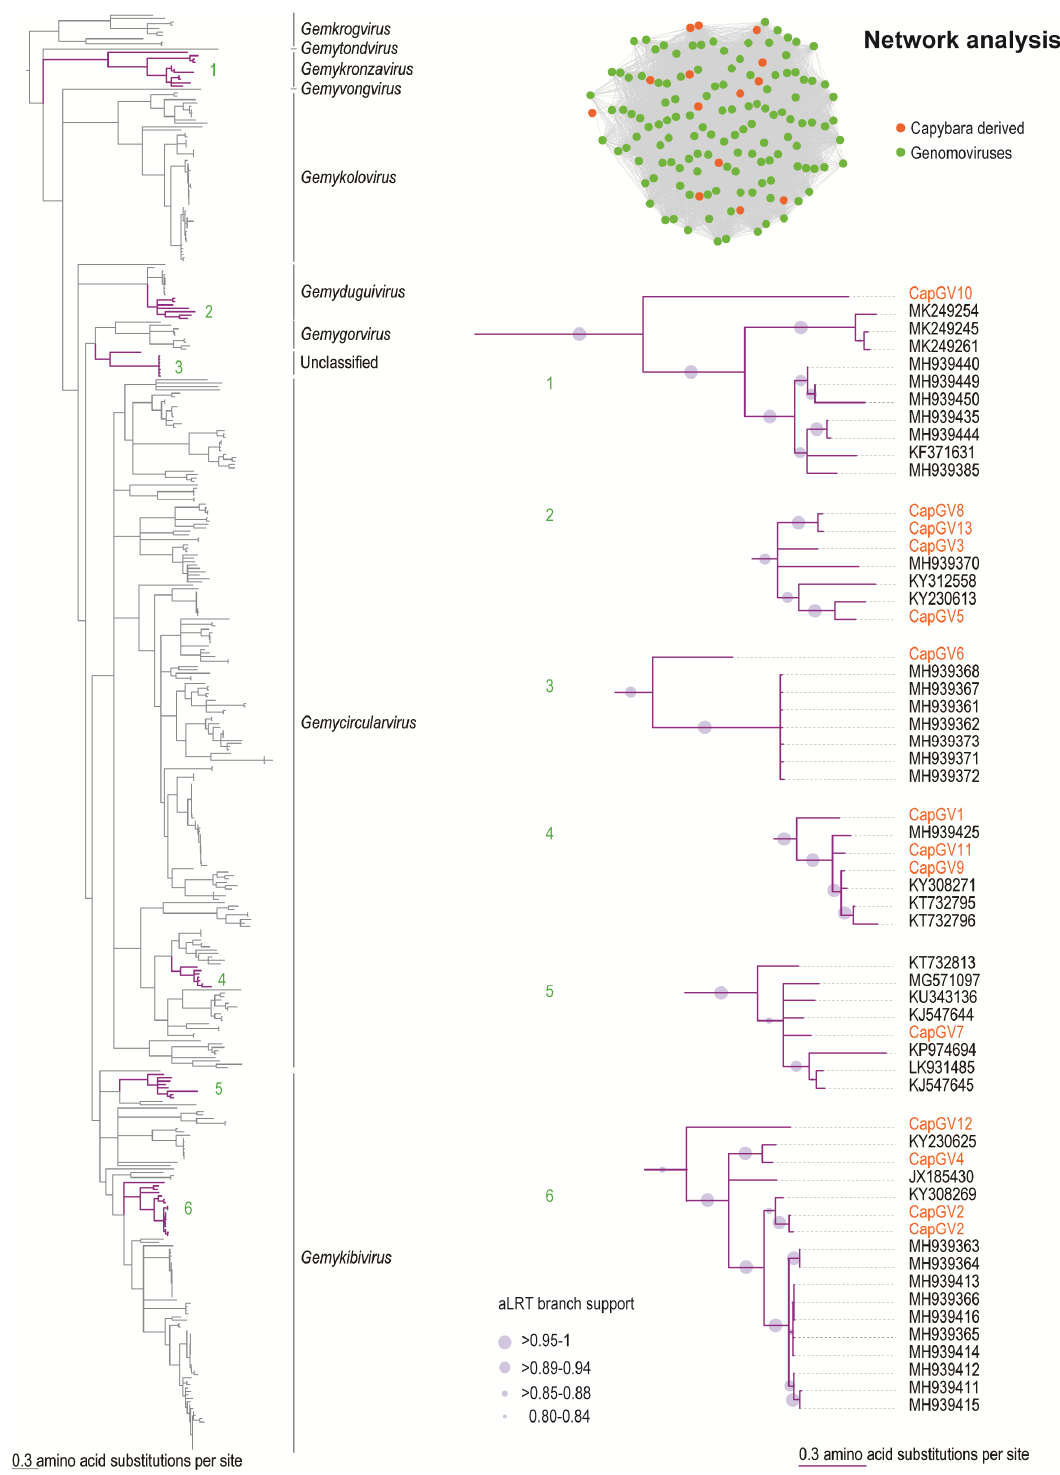
Figure 2. Sequence similarity network analysis and Maximum Likelihood phylogenetic tree of the Rep amino acid sequences of the viruses belonging to the nine Genomoviridae genera. The tree is rooted with Rep sequences of geminiviruses. Branches with aLRT support < 0.8 were collapsed. The Reps of genomoviruses identified in this study are highlighted in orange. Clades containing the capybara associated genomoviruses CapGV1–13 (highlighted in purple) are expanded.